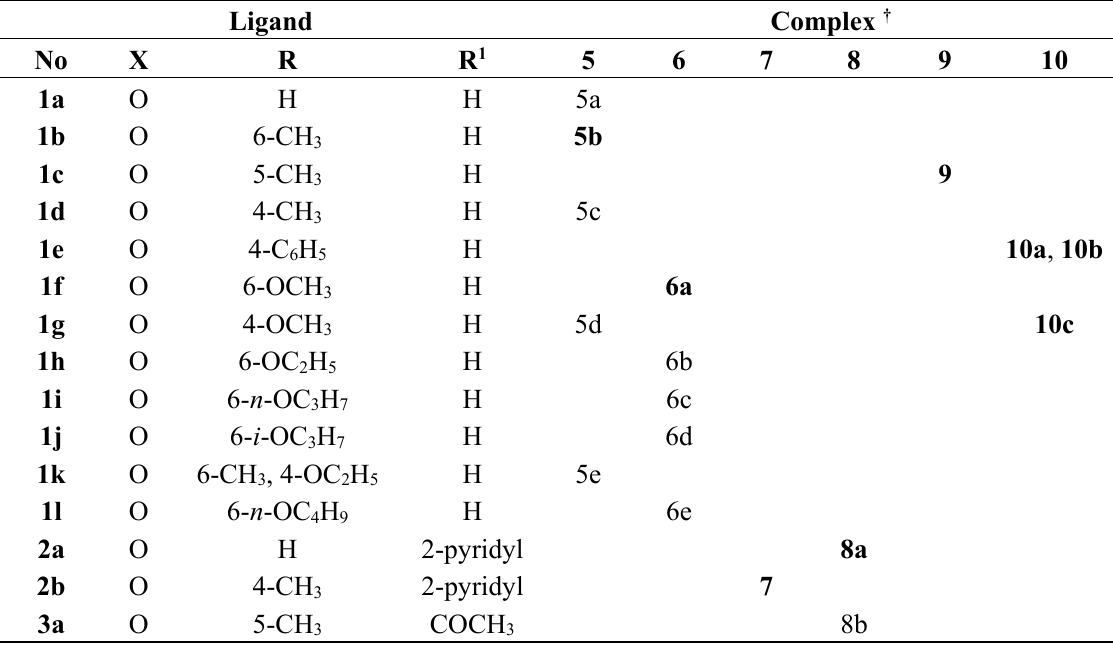
Table 1. List of ligands and copper(II) complexes